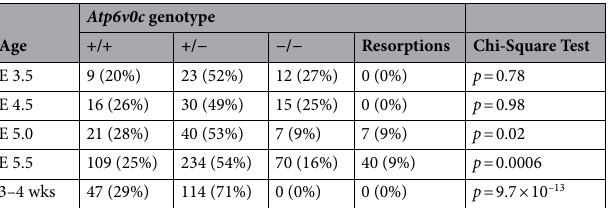
Table 1. Genotypes of progeny from Atp6v0c + /− mating. Timed mating was set up, and the isolated embryos or tails were used to obtain the genomic DNA. We were unable to genotype the